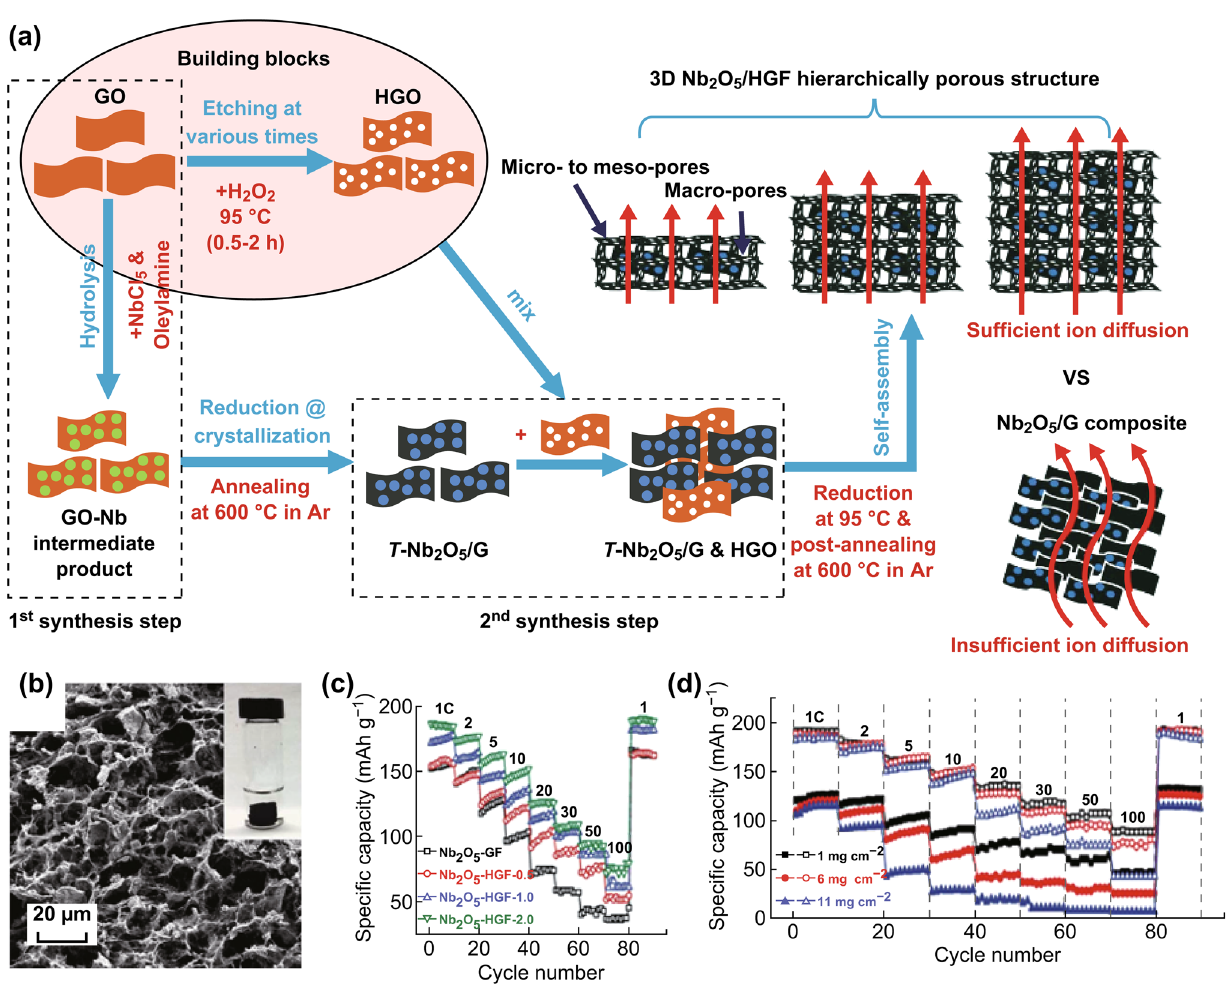
Fig. 5 a Schematic of the fabrication process. b Cross‑sectional SEM image. (Inset) A free‑standing monolithic electrode. c Rate capability at tunable nanoporosity. d Rate performance at different mass loadings. Reprinted with permission from Ref.